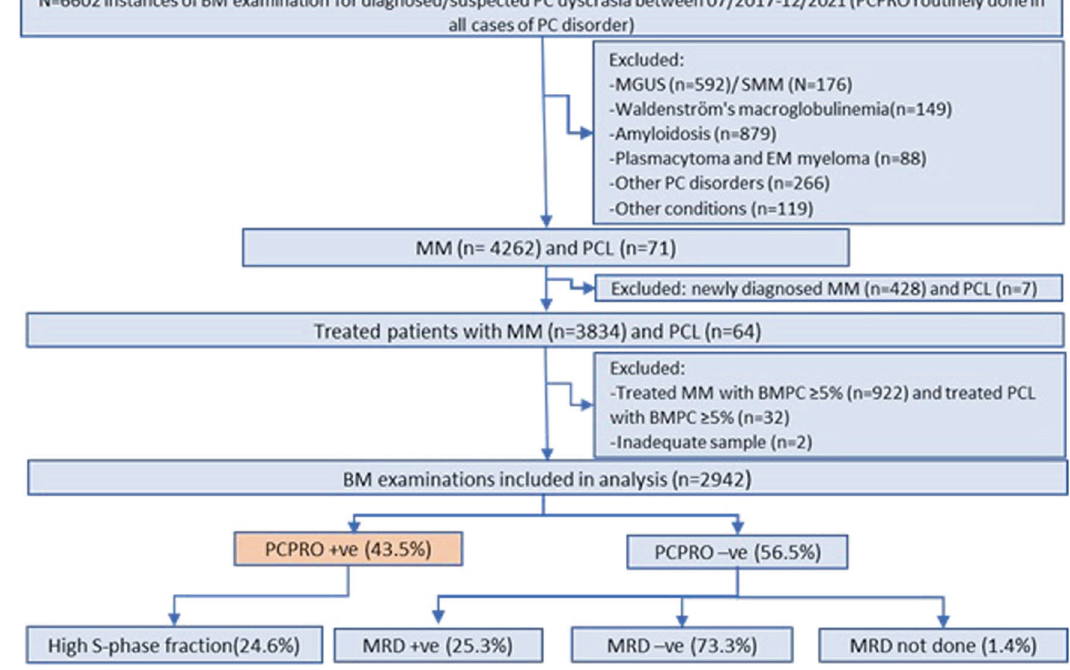
Fig. 1 Flow of patients in the study. We initially identi fi ed all patients with a plasma cell (PC) disorder who underwent plasma cell proliferation (PCPRO) testing. Treated patients with multiple myeloma (MM) and PC leukemia (PCL) who were considered measurable residual disease (MRD) testing-eligible were identi fi ed and the proportion of patients in whom MRD testing was avoided by a positive PCPRO was calculated. BMPC bone marrow plasma cell, EM extramedullary, MGUS monoclonal gammopathy of undetermined signi fi cance, SMM smoldering multiple myeloma. Table 1. Analytical and operational differences between the screening PCPRO and NGF MRD